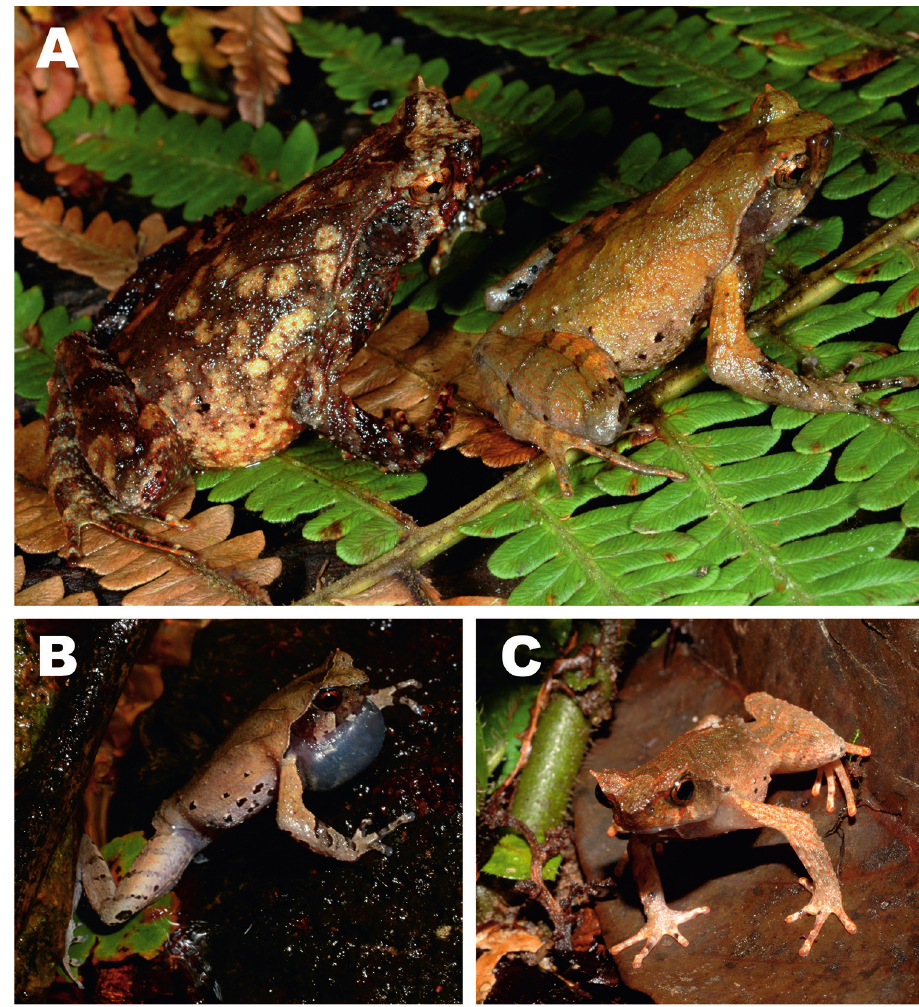
Figure 14. Ophryophryne elfina sp. n. in situ: A Two syntopically collected males of Ophryophryne gerti (left) and Ophryophryne elfina sp. n. (right) in Chu Yang Sin N.P., Dak Lak Prov., Vietnam, 1750 m a.s.l., photo by N.L. Orlov B calling adult male of Ophryophryne elfina sp. n. in Nui Chua Mt., Nui Chua N.P., Ninh Thuan Prov., Vietnam, 780 m a.s.l., photo by S.N. Nguyen C adult male of Ophryophryne elfina sp. n. in calling position in Hon Ba N.R., Khanh Hoa Prov., Vietnam, 1510 m a.s.l., photo by L.T. Nguyen.